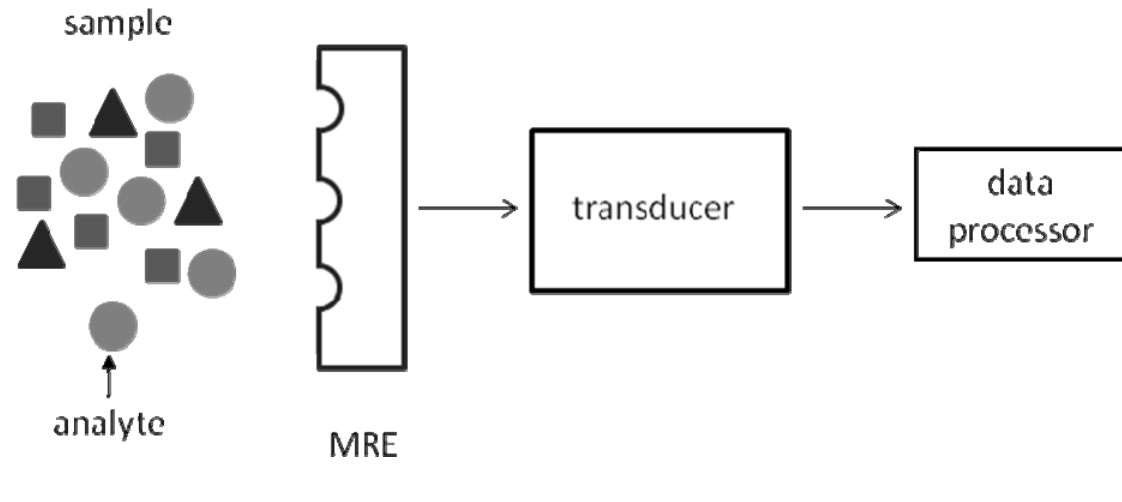
Figure 1. Fundamental components of a biosensor. A biosensor consists of a molecular recognition element (MRE), a physical transducer and a data